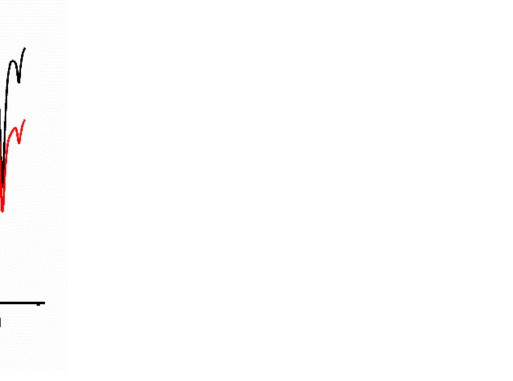
Figure 5. The FTIR spectra of DMEDA solution (30 wt.%) in sulfolane (Sulf) before and after CO 2